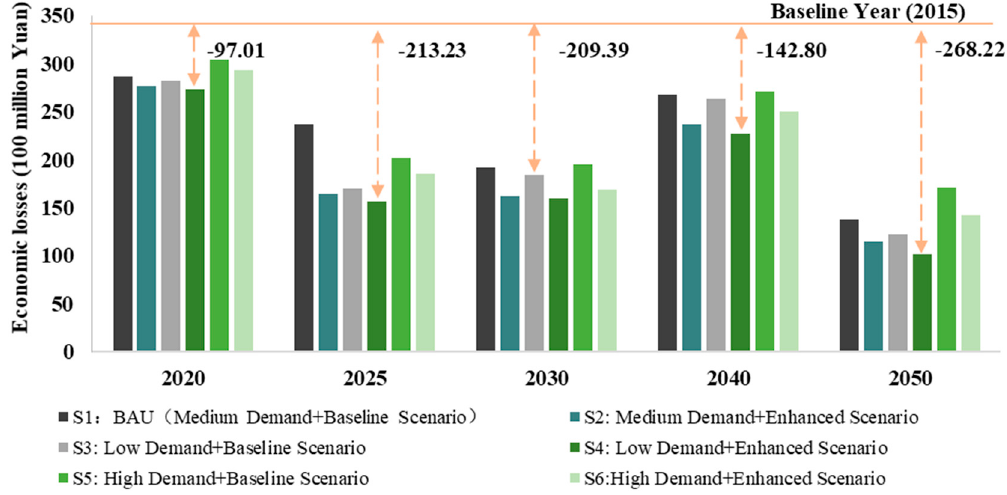
Figure 5. Health economic losses of SO 2 emissions under different scenarios in the steel sector.